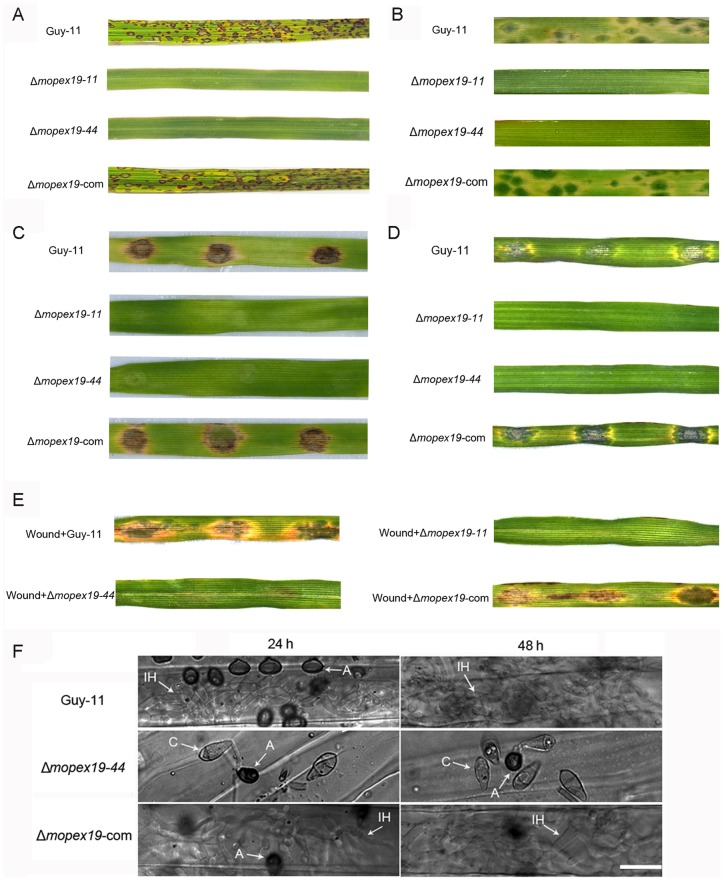
Pathogenicity test of Δmopex19.(A) Spray-inoculation with conidial suspension (1×105 conidia/ml) of Δmopex19, wild-type and complemented strains on 2-week-old rice cultivar CO39. The symptoms were recorded at 7 days post-inoculation. (B) Spray-inoculation with conidial suspension (2×104 conidia/ml) on 7-day-old barley cultivar ZJ-8. The symptoms were recorded at 4 days post-inoculation. Detached barley leaves inoculated with 5-mm mycelial plugs (C) or with 20-μl droplets of conidial suspensions (2×104 conidia/ml) (D) were cultured for 4 days. (E) Wounded barley leaves inoculated with 20-μl conidial suspensions (2×104 conidia/ml) were cultured for 4 days. (F) Droplet-inoculated barley leaves were sampled at 24 and 48 h post-inoculation, discolored, and examined under a light microscope. The conidia (C), appressoria (A) and invasive hyphae (IH) are marked. Bar = 20 μm.